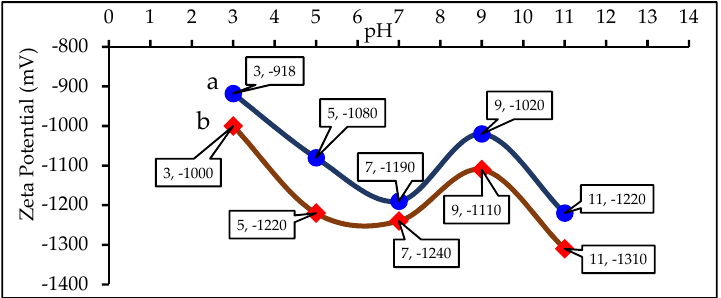
Figure 5. Zeta Potential of ( a ) activated carbon treated with 0% KMnO 4 HTP and prepared at 350 °C and ( b ) activated carbon treated with 1% KMnO 4 HTP and prepared at 350 °C.